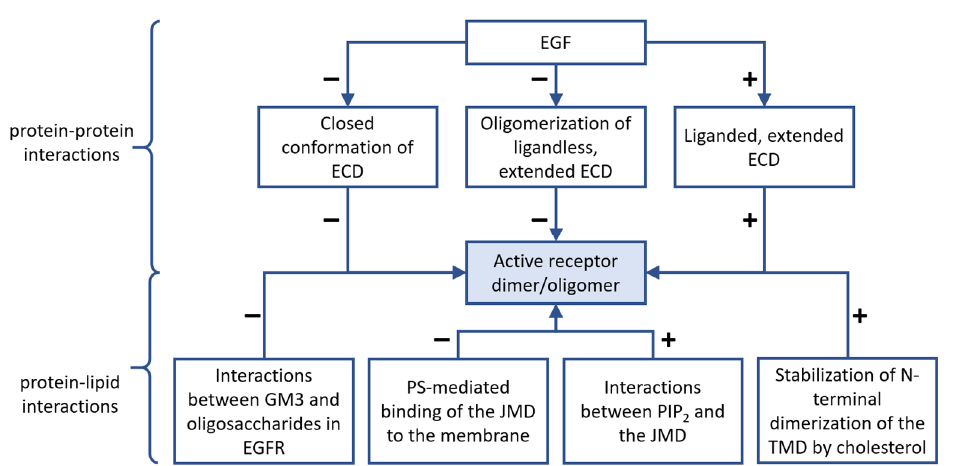
Figure 5. The formation of the EGFR signaling unit is at the crossroads of activating and inhibitory factors. The physiological aim of the complex network governing receptor dimerization and oligomerization is to keep ligandless receptors in an inactive state and to enable the formation of signaling competent units after growth factor binding. Ligandless ECDs prevent the formation of active, signaling competent dimers/oligomers, while the ligand-bound ECD favors their formation by tilting the TMDs such that they favor the formation of asymmetric KD dimers (not explicitly shown in the figure). These processes involve conformational transitions of the receptors themselves, but they are supported by protein–lipid interactions that can also foster or block the formation of active receptors, which must probably form larger-order associations to become signaling competent.